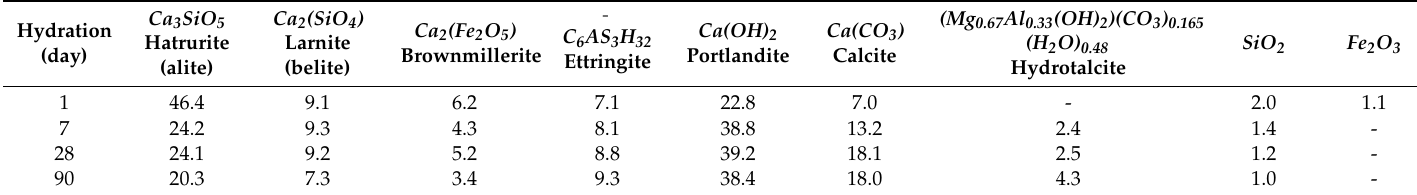
Table 3. Mineral composition of reference sample with cement and fly ash (FA).